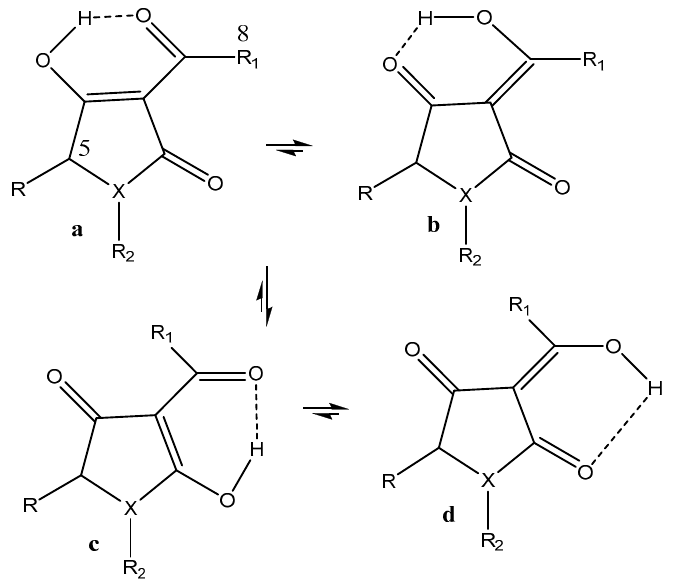
Figure 14. Tautomeric equilibria of 3-acyl tetronic (X=O) and tetramic (X=N) acids. ( a – d ) are the different enolic forms.